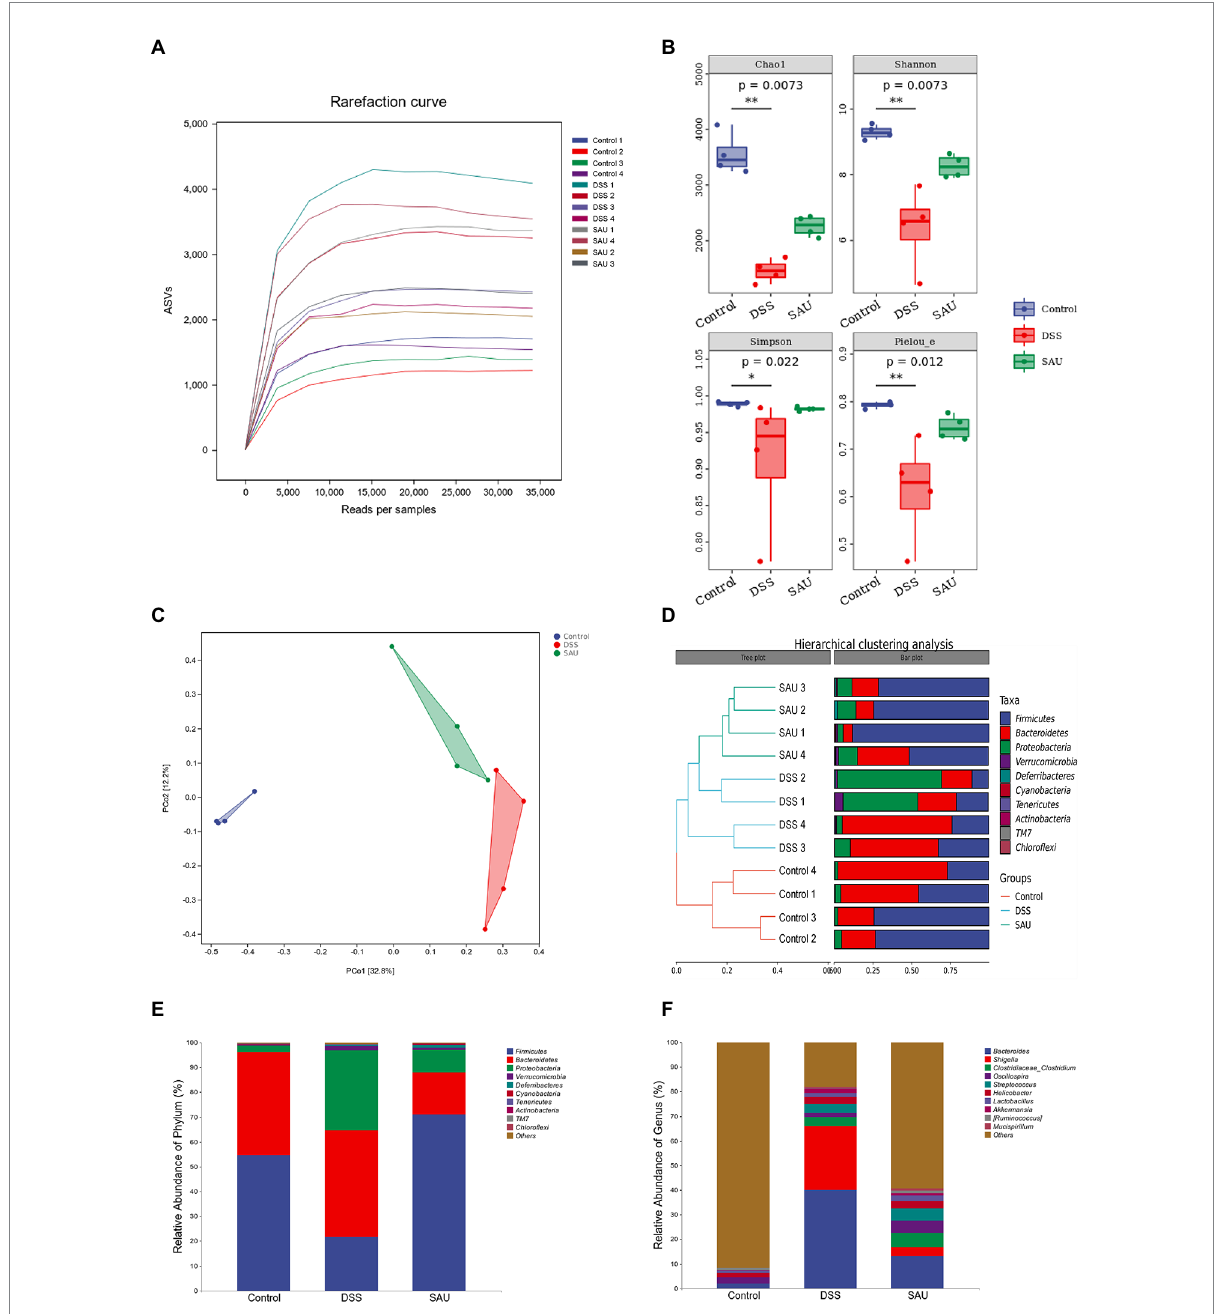
FIGURE 5 Effects of sauchinone on the composition and structure of gut microbiota in DSS-induced UC mice. (A) The rarefaction curves. (B) α -diversity based on the Shannon, Chao 1, Simpson, and Pielou indices. (C) Bray-Curtis-based PCoA plot based on the ASV level ( p = 0.001). (D) Hierarchical clustering analysis at the phylum level. (E,F) Average taxonomic profile analysis at the phylum and genus